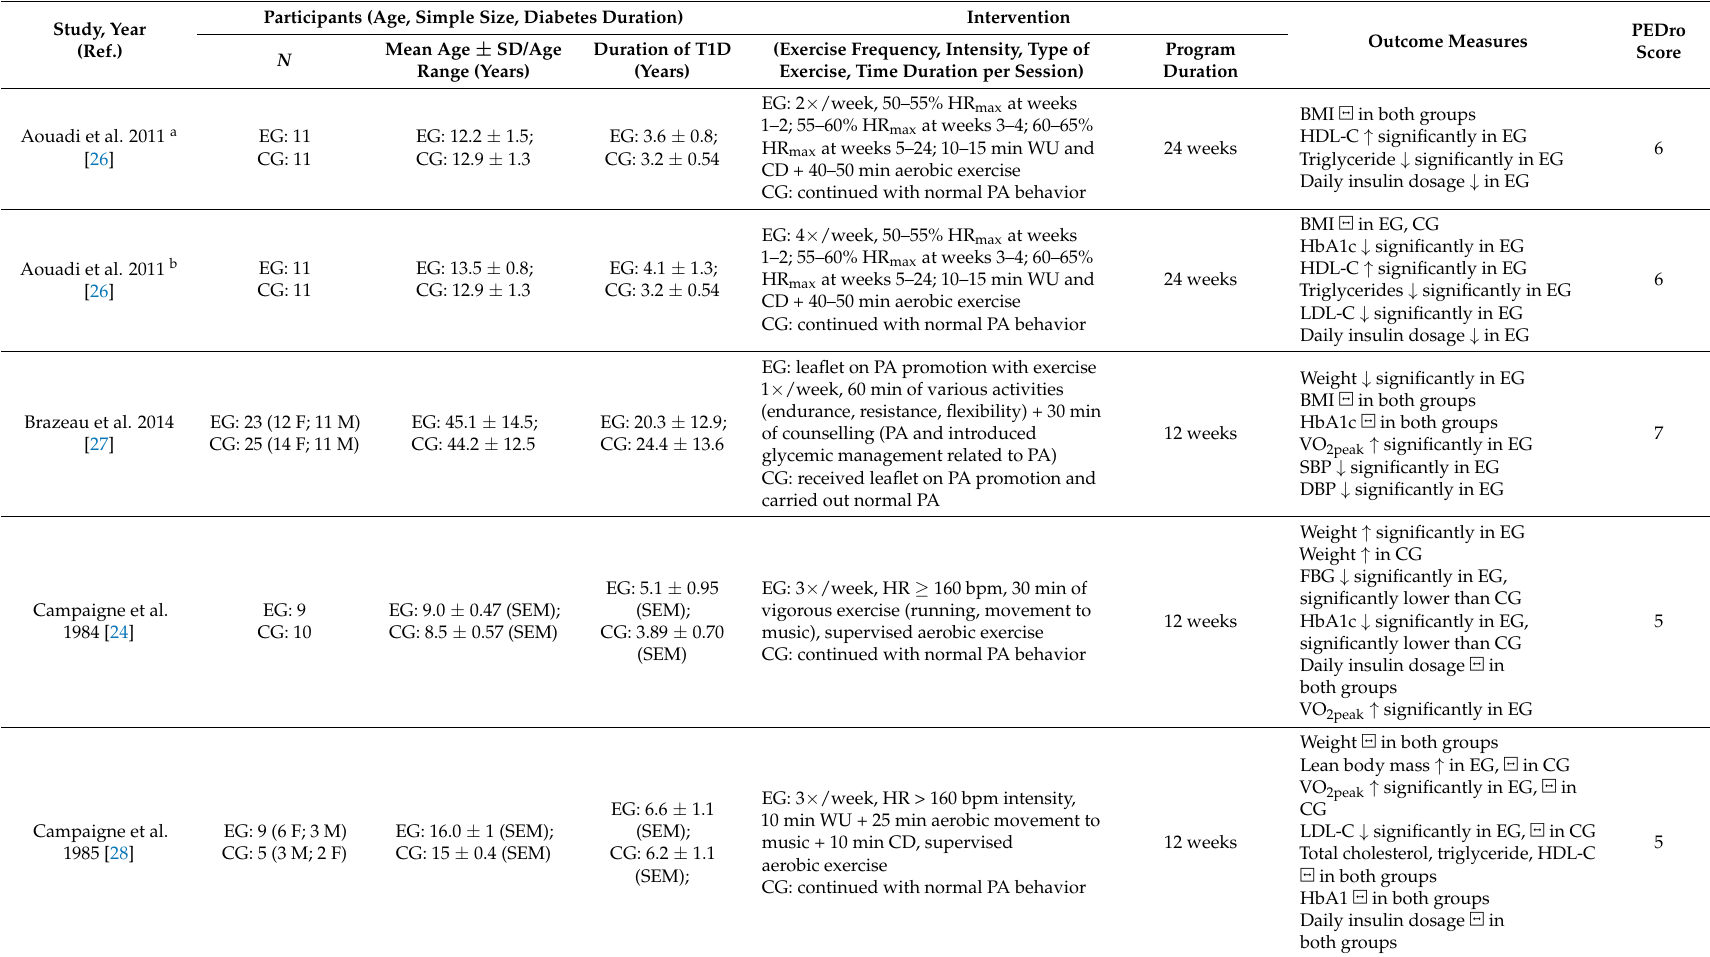
Table 1. Characteristics of the included studies.